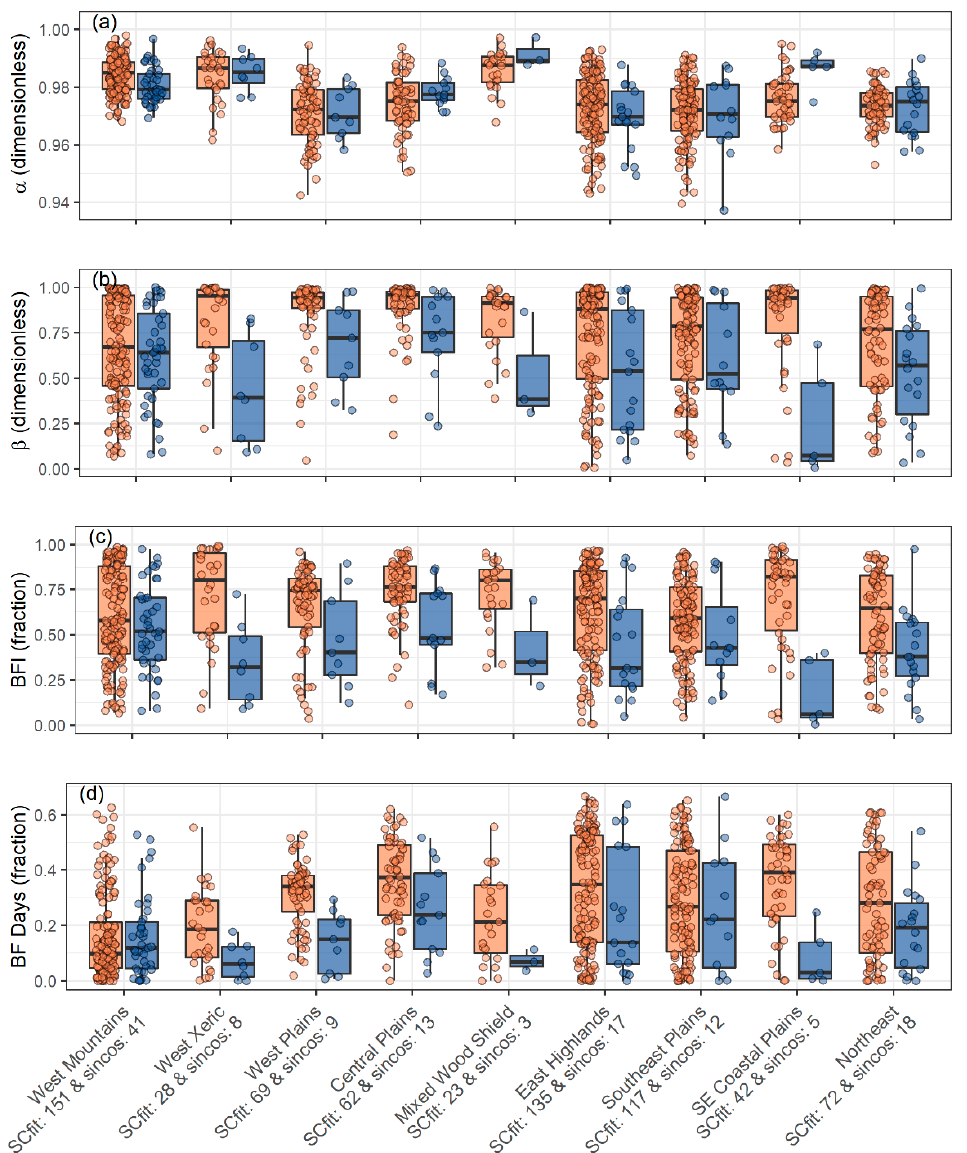
Figure 4. Distributions of ( a ) α , ( b ) β , ( c ) BFI, and ( d ) BF Days for each aggregated ecoregion [34,58]. “Southeast” is abbreviated as “SE”. The orange box plots represent SCfit model types and the blue box plots represent sin-cos model types. The number of samples are listed by model type in the x-axis.